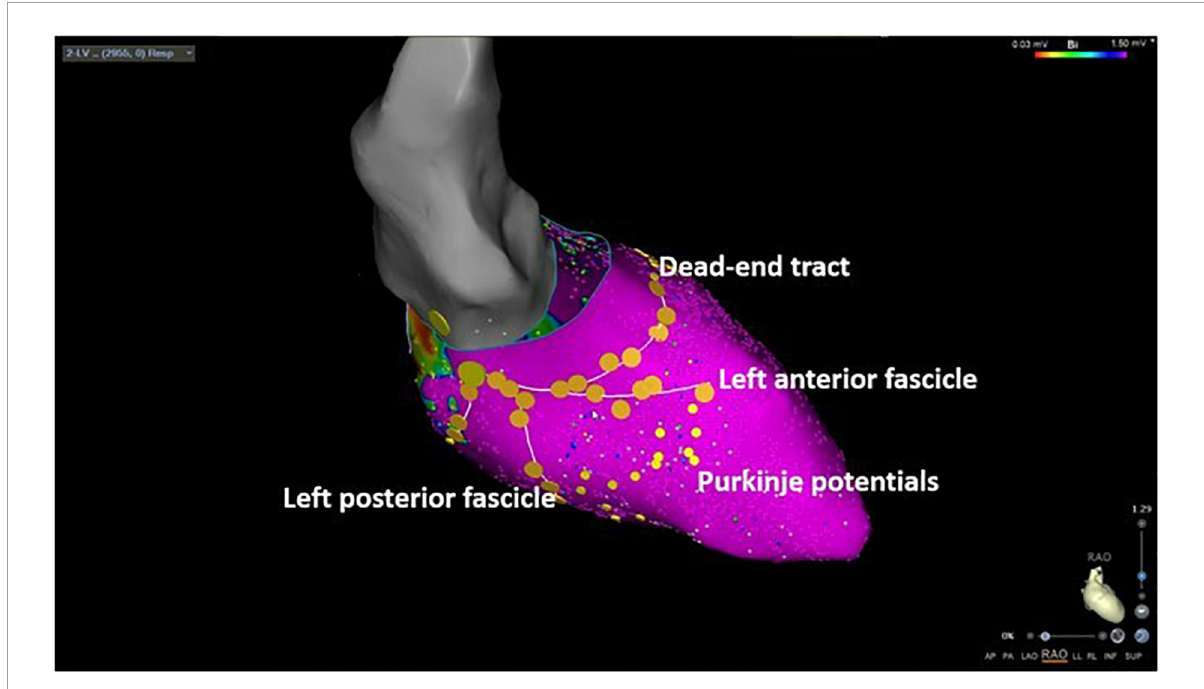
FIGURE1 Three-dimensional electroanatomic mapping of a patient undergoing selective Purkinje de-networking (PDN) due to recurrent ventricular fibrillation. The left anterior and left posterior fascicles as well as the dead-end tract were marked by large yellow tag points. Purkinje potentials were marked by small yellow tag points. The target region for ablation was the area between the left anterior and left posterior fascicle aiming at the elimination of all visualized Purkinje